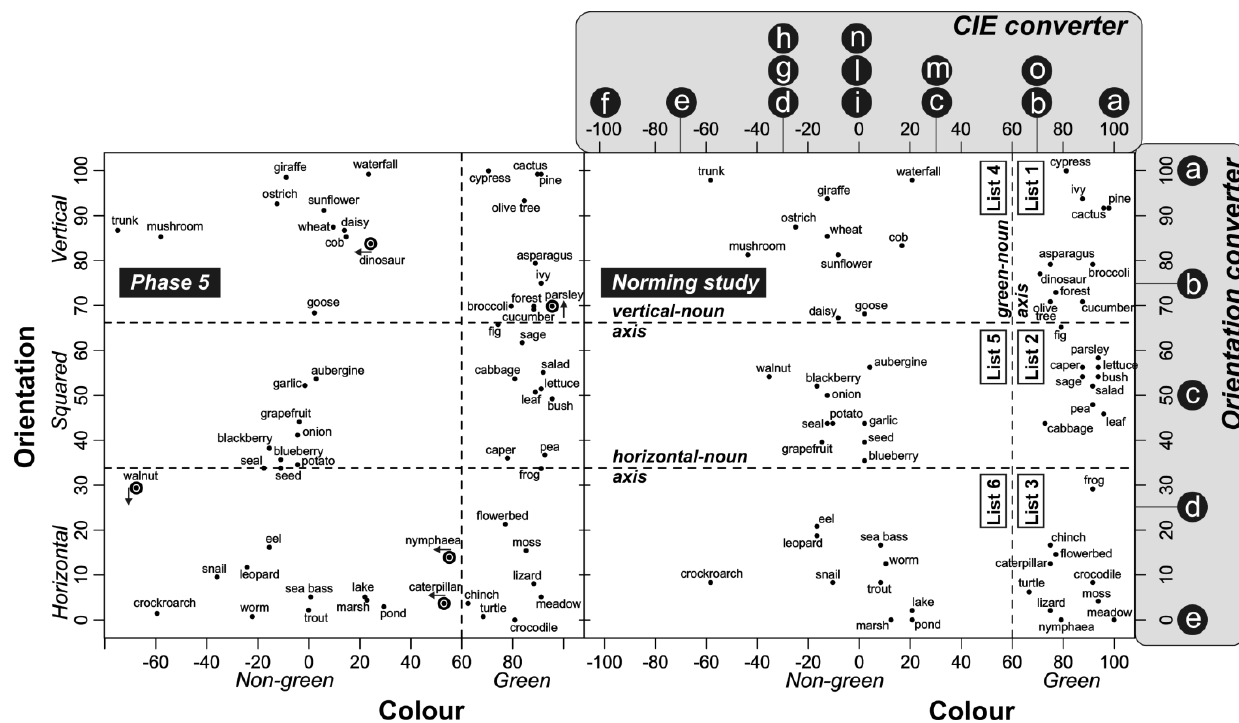
Figure 2. Referents of critical nouns used in the categorization task are represented in a two-dimensional space spanned by estimated color and orientation axes. Location of noun referents in the space is defined by mean values of their color and orientation estimates as measured in Phase 5 ( left plot) and in the norming study ( right plot). Tables used for numeric conversion of collected color and orientation estimates are displayed in the upper right corner of the figure. In each plot, two horizontal dashed lines indicate the borders among vertical, squared, and horizontal orientations, whereas a vertical dashed line denotes the border between green and non-green colors. In the right plot (norming study), the intersecting dashed lines subdivide the space into six regions, each containing 10 nouns that refer to objects with the same estimated color and orientation (thus included in the same stimulus list). In the left plot (Phase 5), an arrow marks the nouns that changed their spatial location relative to the norming study (the arrowhead points away from the list originally containing the